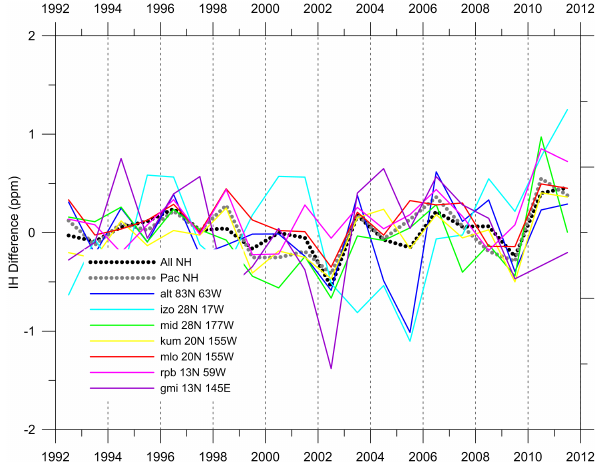
Figure 2. North–south CO 2 differences using other NH sites from the NOAA network: NH site minus cgo, using annual average base- line data (calendar year, plotted mid-year). Latitude and longitude of sites are provided in the legend.